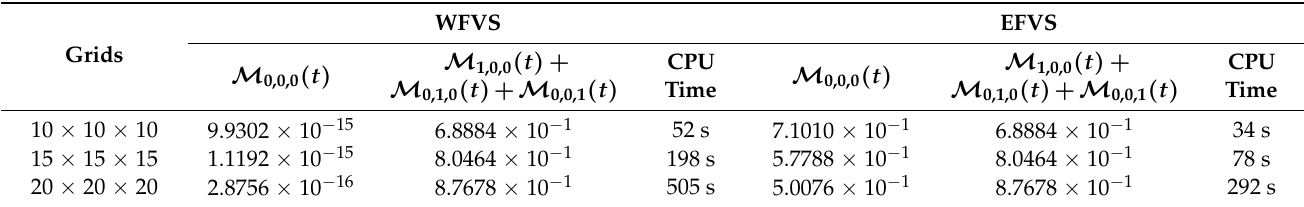
Figure 7. Comparison of zeroth- and first-order moments with selection function S = φ ( x ) , and different breakage functions b 5 , b 6 . Table 13. Relative error for the weighted moments at different grid points for the test case with S = φ ( x ) and breakage function b 5 at t = 10.